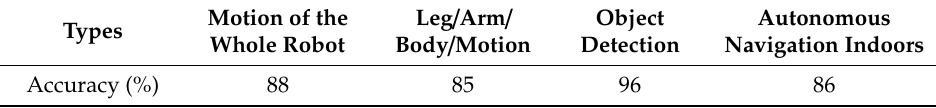
Table 12. Average accuracies of di ff erent types of speech